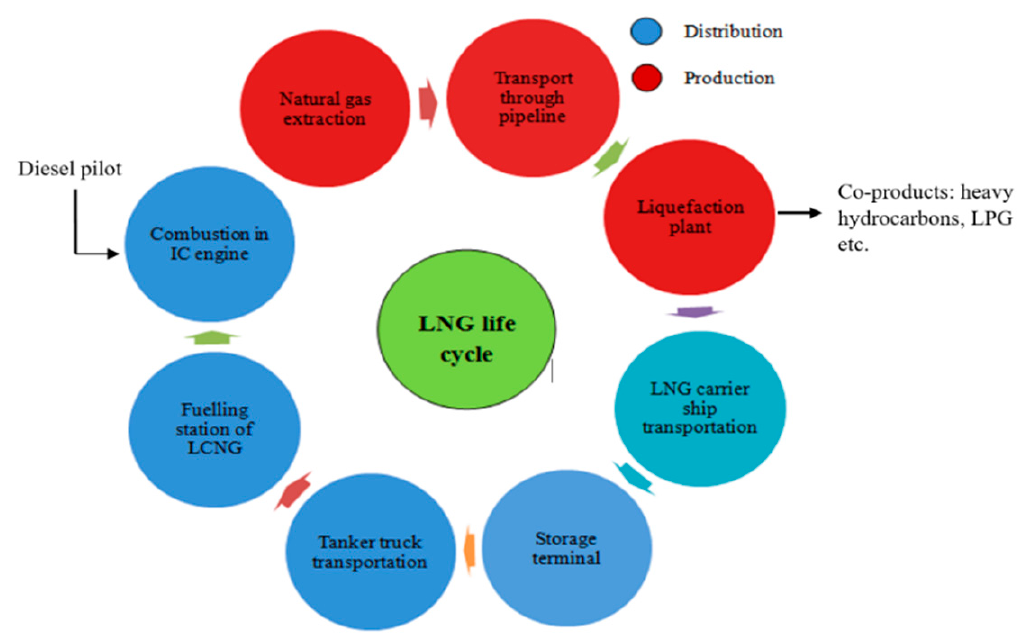
Figure 2. LNG life cycle (adapted from [15]). Note: Permission granted from the publisher (Elsevier-Applied Energy).